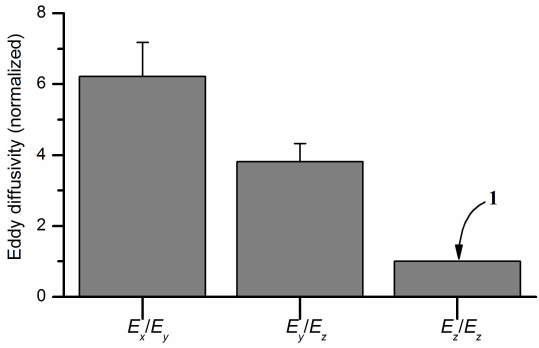
Fig. 10. Level of anisotropy in the turbulent flow below the sea-ice, as reflected in the ratios between the eddy diffusivities ( E x ,E y , and E z ) in the x, y, and z